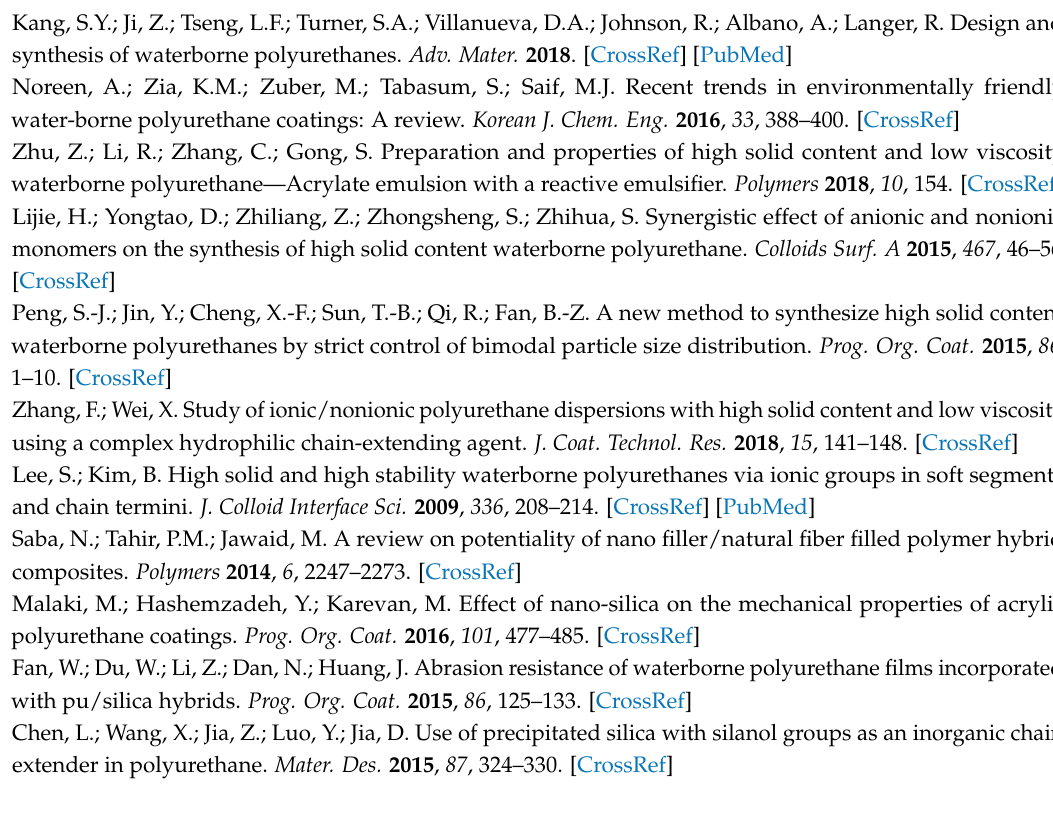
Figure S1: Phase images of WPU and WPU/Silica coatings, Figure S2: Photos of WPU and WPU/Silica coatings. Author Contributions: Y.H. and Z.X. conceived and designed the experiments. Y.H. carried out the laboratory experiments, analyzed the data, interpreted the results, and prepared the figures. Y.H. and J.H. wrote the